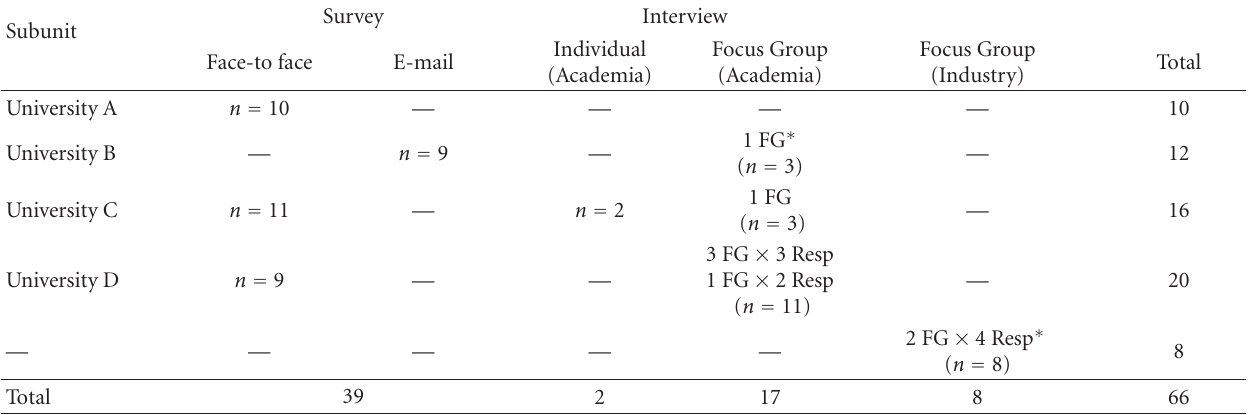
Table 1: Instruments and respondent distribution.